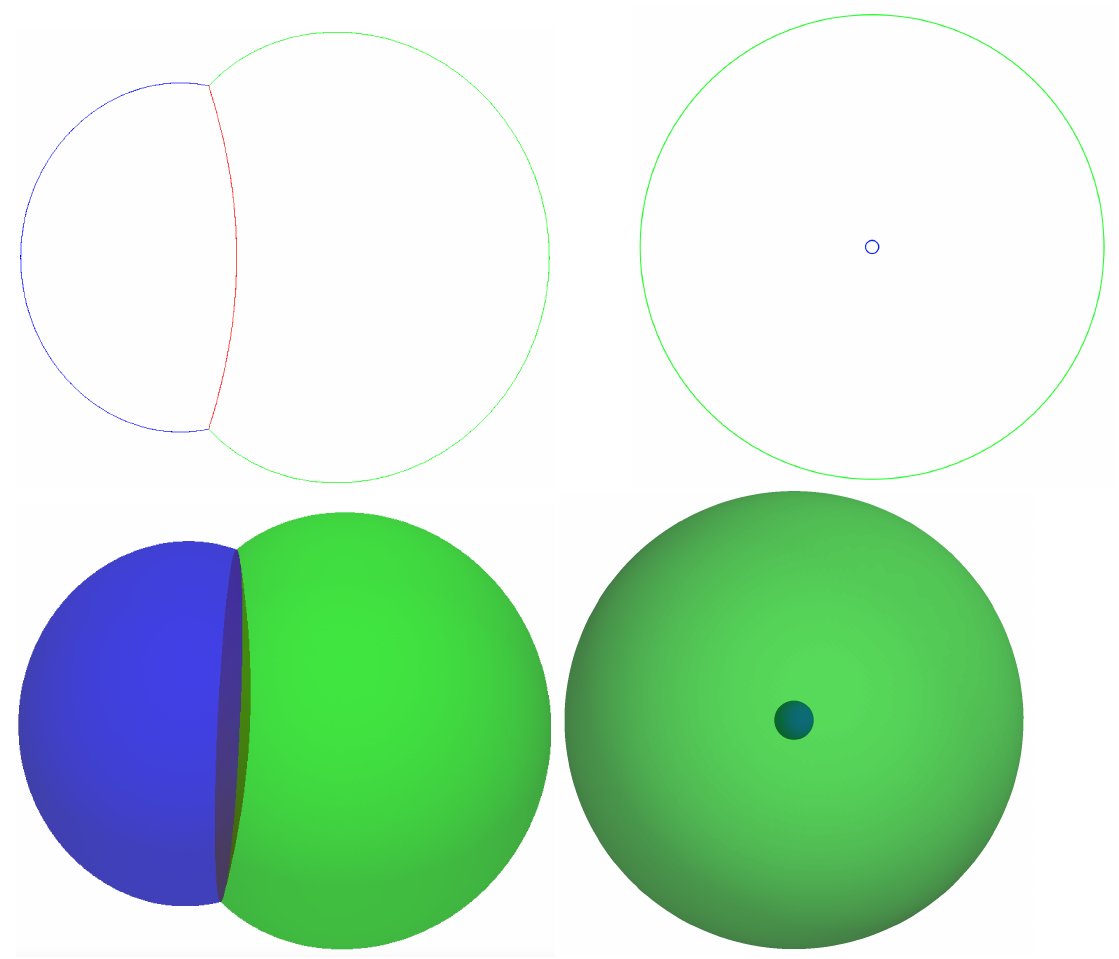
2 is sometimes a standard double